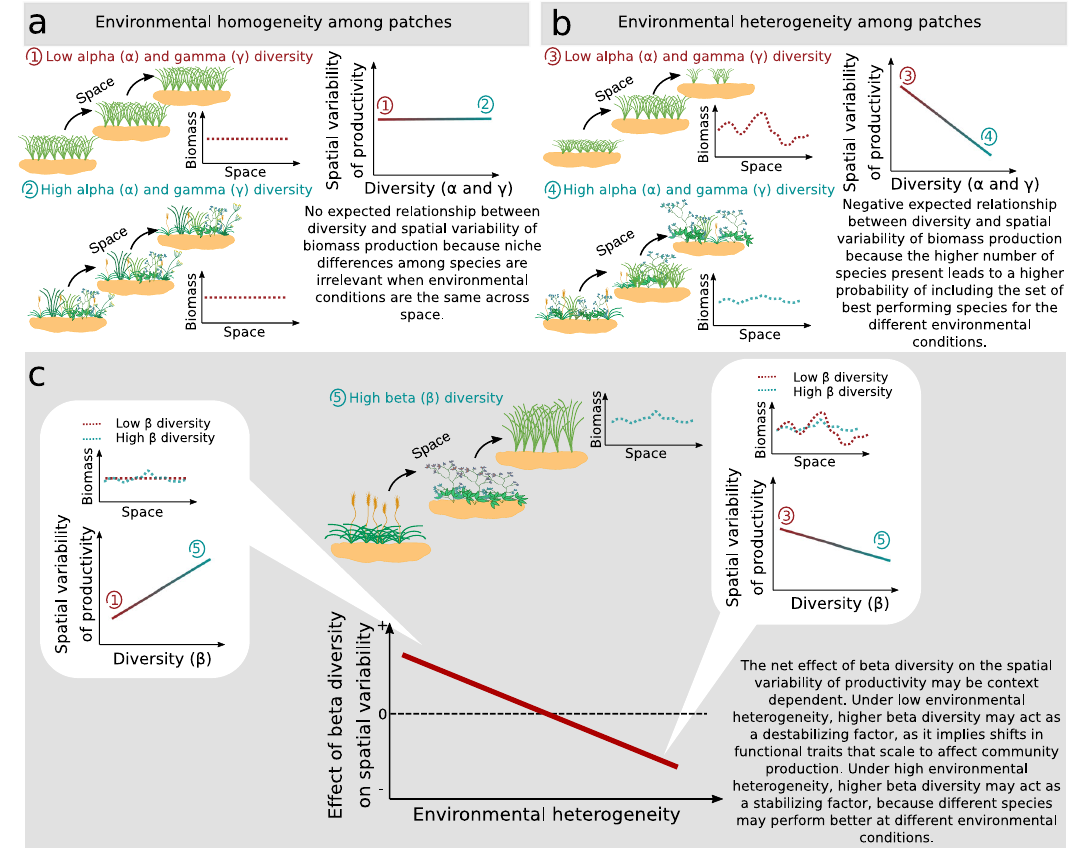
Fig. 1 | Conceptual fi gure illustrating the effect of different scales of biodi- versity on the spatial variability of aggregate ecosystem functions. The insur- ance hypothesis postulates that biodiversity buffers aggregate ecosystem functions (e.g., biomass production) against environmental fl uctuations, resulting in less variation within more diverse systems. This hypothesis was originally pos- tulated for environmental fl uctuations over time, but may also apply to spatial heterogeneity. a When environmental conditions are homogeneous, niche differ- ences among species are non-important, and the variability of an aggregate eco- system function is unaffected by alpha or gamma-diversity. b In contrast, in heterogeneousenvironments,differentenvironmentalconditionsprovideanarray of niches. In this scenario, a species may be functionally insigni fi cant under some